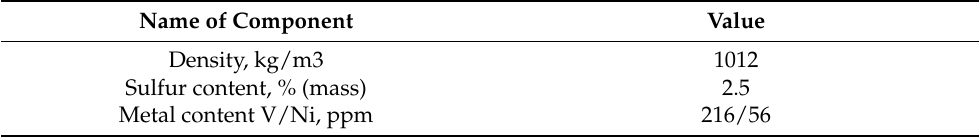
Table 3. Quality indices of initial stock (vacuum residue).